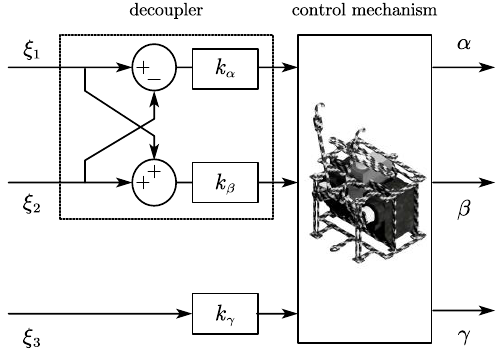
Figure 13. The decoupler used in attitude control.